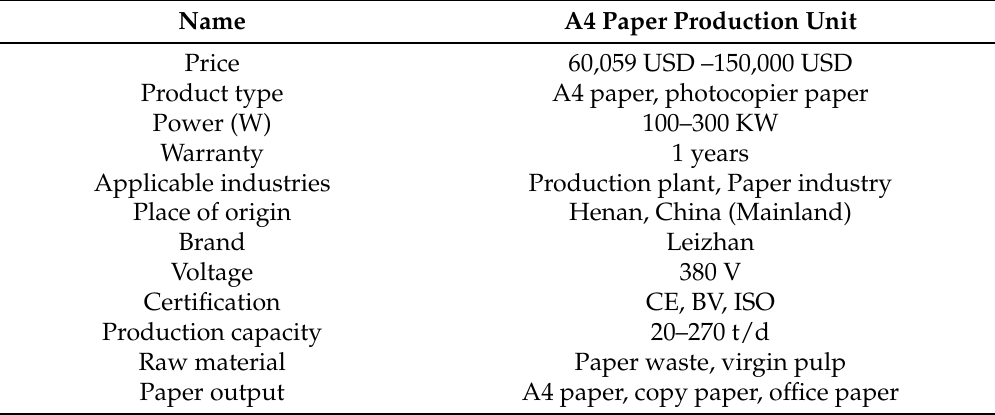
Table 1. Detailsof production of the machinery. Source: